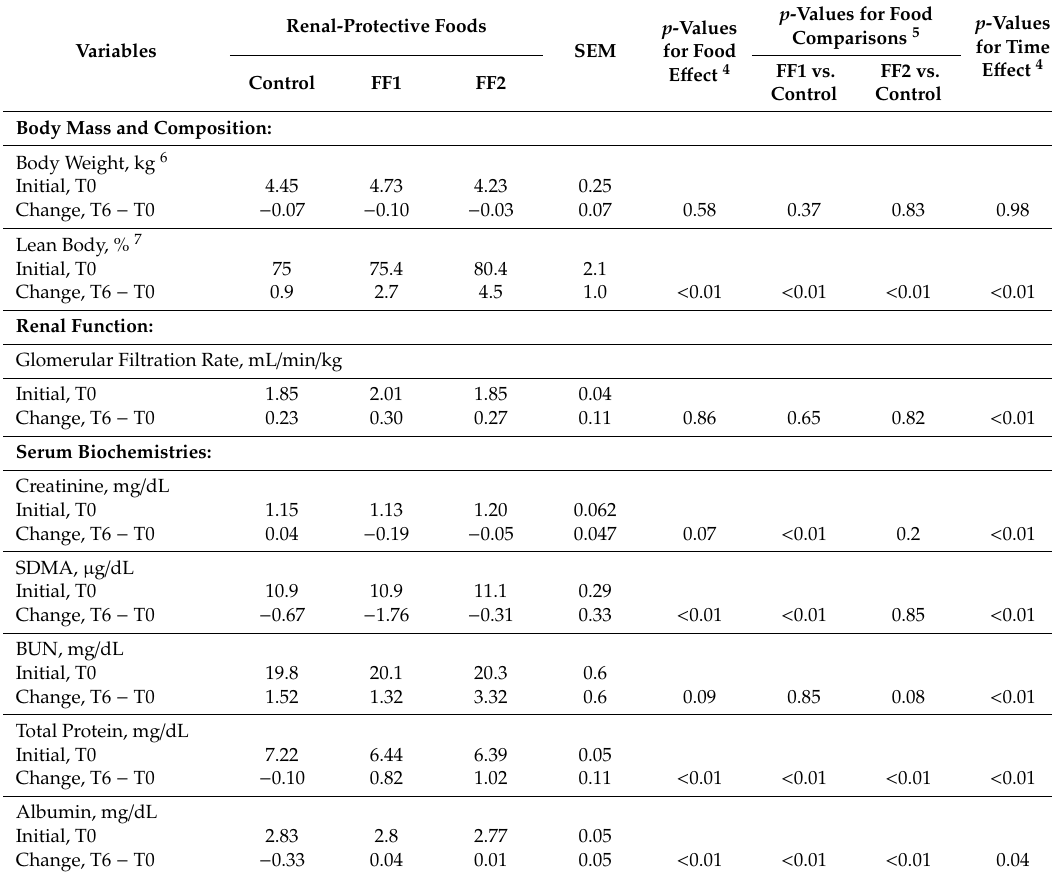
Table 4. E ff ect of feeding control 1 or two functional foods (FF1 and FF2) 2 for six months (T6) on body composition, renal function, and serum metabolite concentrations in cats compared with their baseline values (T0) 3 . Renal-Protective Foods Variables Control FF1 FF2